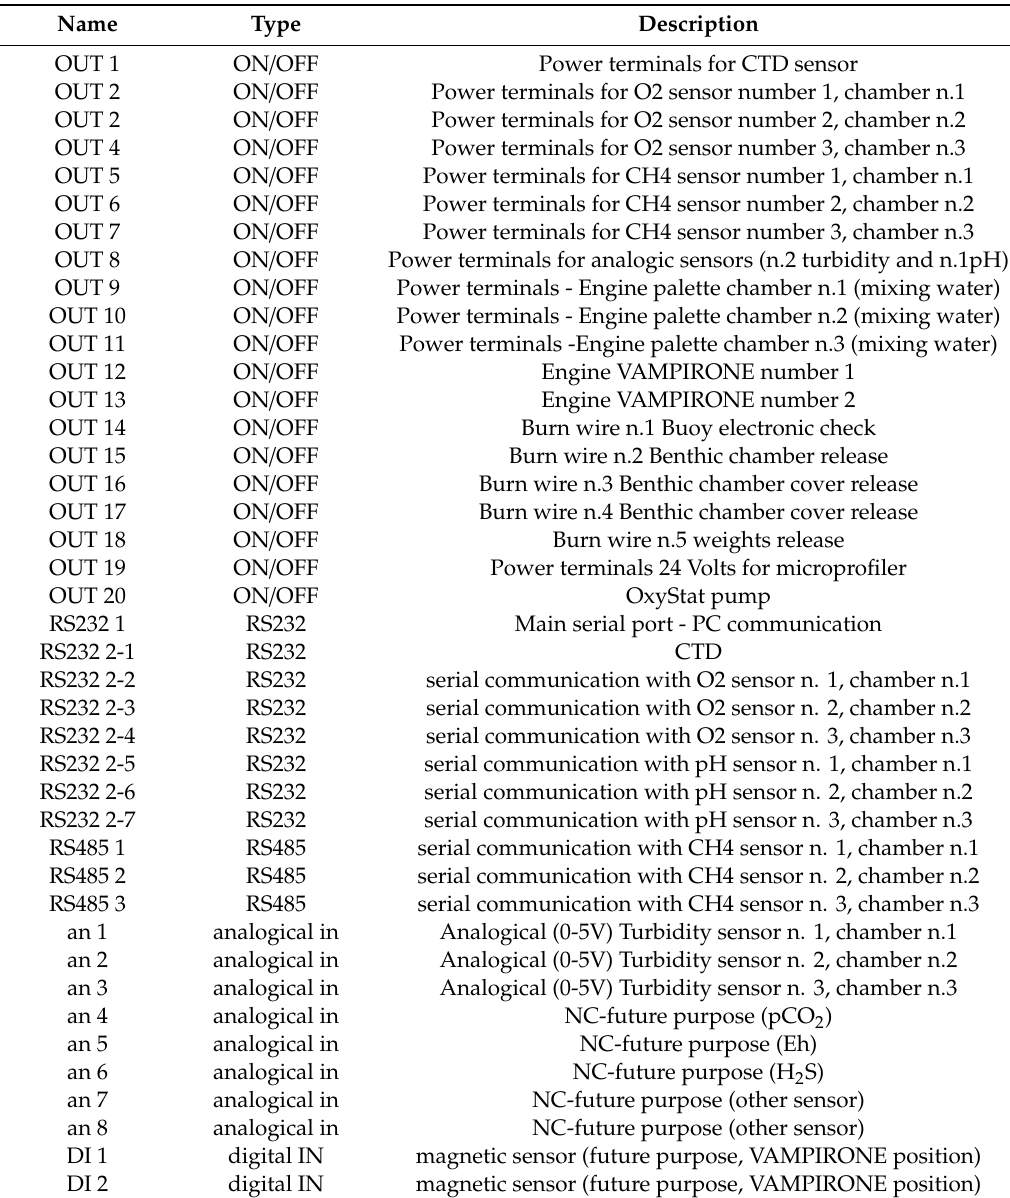
Table A2. Configurations of the general inputs and outputs of the electronic of the Amerigo